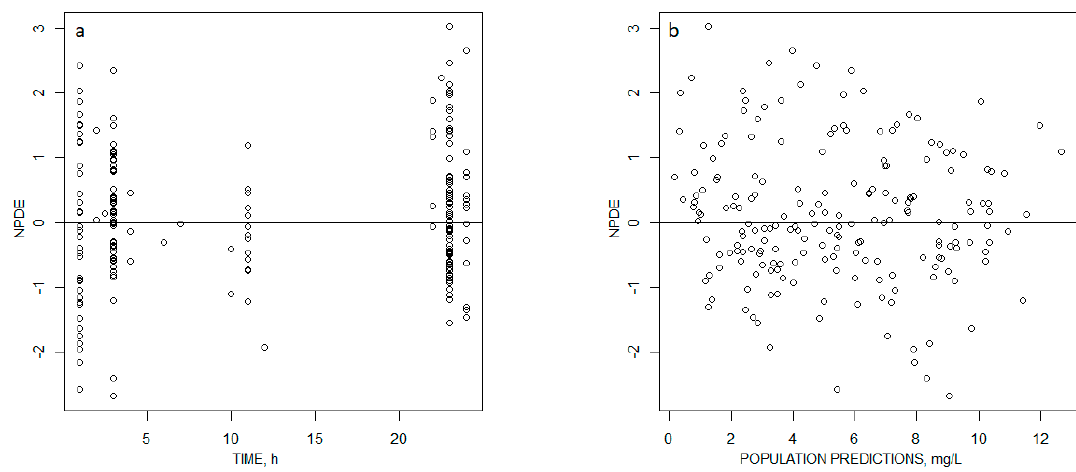
Figure 2. Normalized prediction errors (NPDE) with respect to ( a ) time after dose, and ( b ) population predictions.